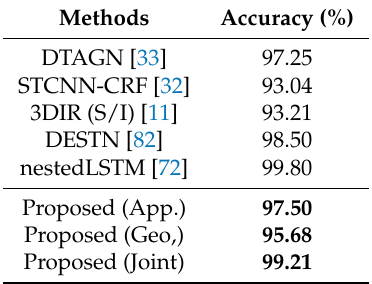
Table 6. The performance comparison of the recognition accuracy in the CK+ dataset